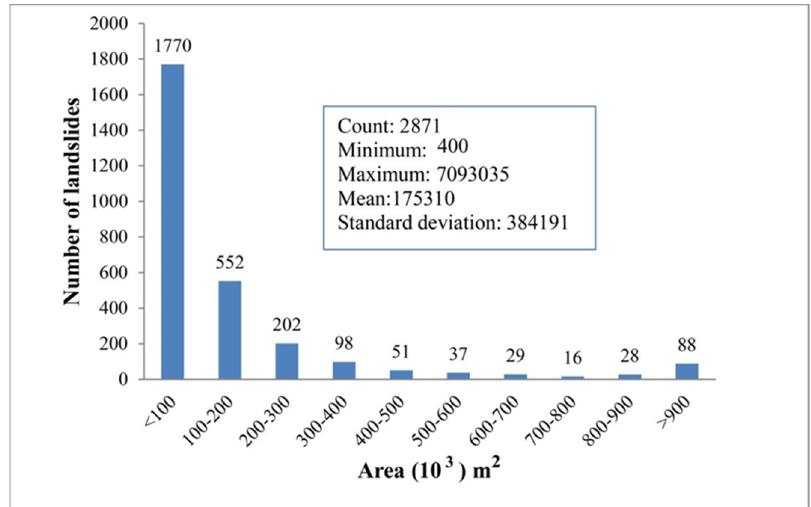
Figure 2. The number of landslides in Zanjan province based on their area. Table 1. Employed information and their sources in the current